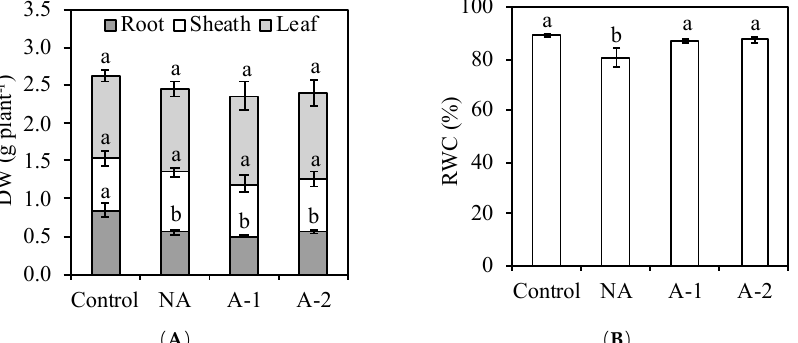
Figure 1. Effects of 10-days sodic-alkalinity with 100 mM NaHCO 3 on plant dry weight (DW) ( A ) and leaf relative water content (RWC) ( B ) of pre-acclimated rye. Rye plants were pre-acclimated by 0 mM NaHCO 3 (NA) and 1 and 2 mM NaHCO 3 (A-1, A-2) for 10 days. Control plants were consistently